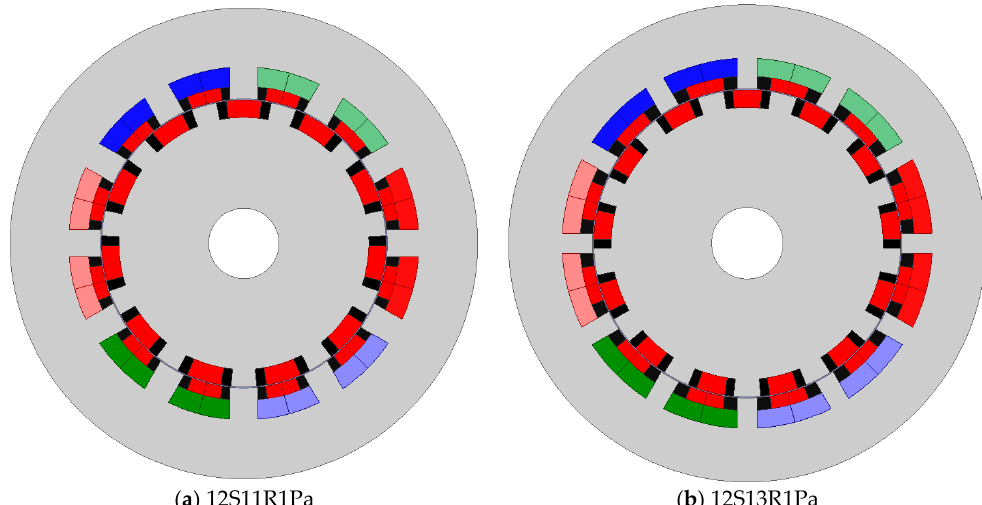
Figure 7. Twelve-stator-slot SSDPM machines with a different rotor slot number. ( a ) 12S11R1Pa; ( b ) 12S13R1Pa.